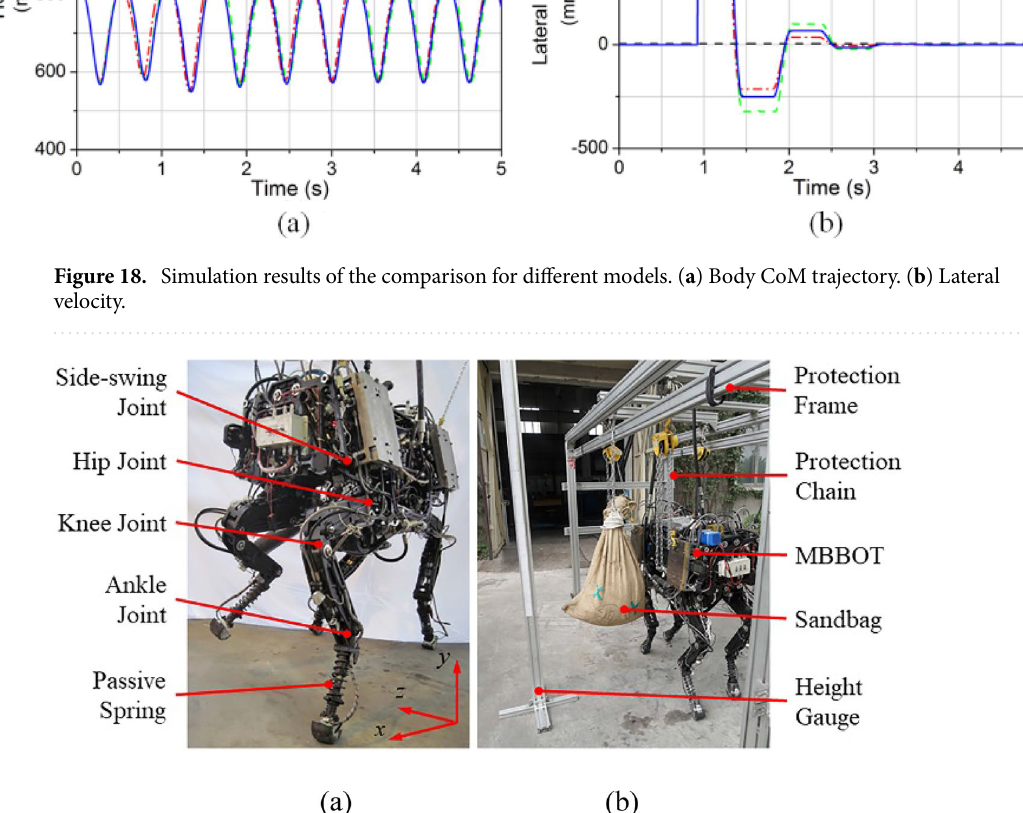
Figure 19. Photos of the experimental prototype and experimental plat-form. ( a ) Experimental prototype named MBBOT. ( b ) Experimental platform for the lateral